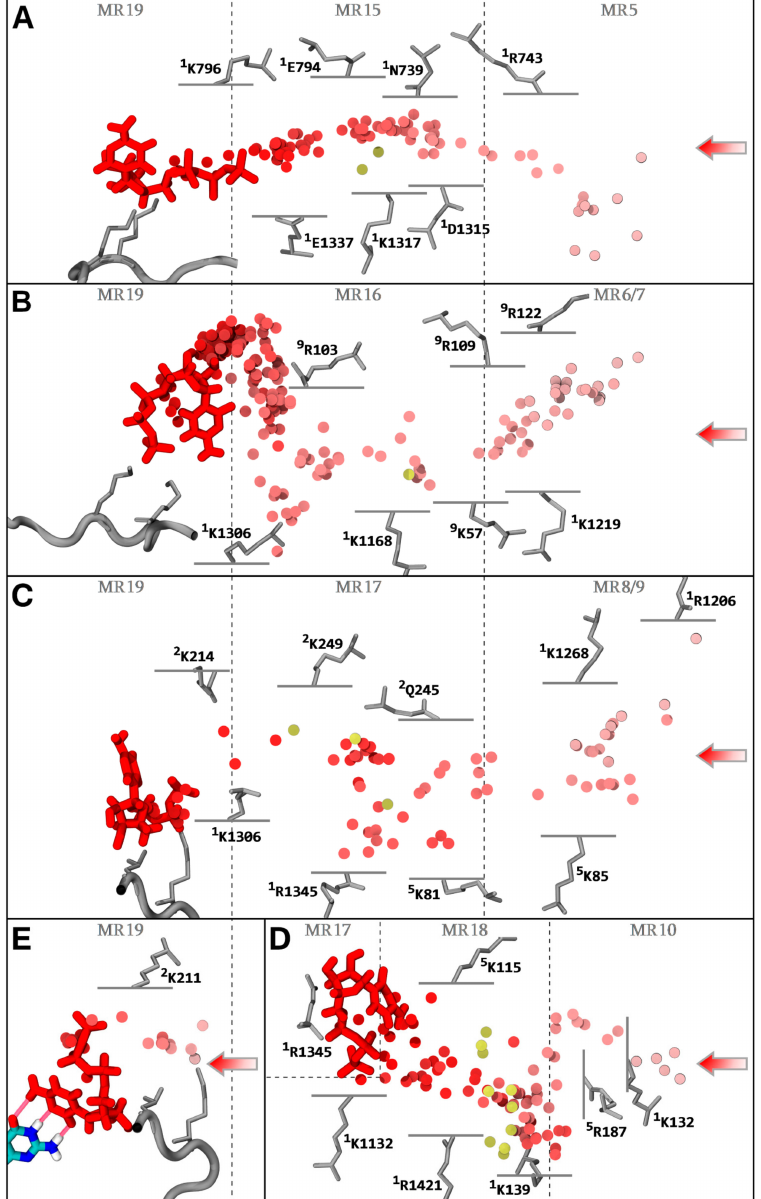
Figure 6. NTP loading through CH1. The center of mass of the NTP-MgB molecule along the di ff usion trajectories is shown as a series of discs, color coded from light red to red, chronologically. The NTP substrate (MgB not shown) at the end ( A – E , red) of the displayed trajectory, and the i + 1 dNMP DNA register (( E ) colored by atomic type), are shown in stick representation. The hydrogen bonds completing the CH1 di ff usion process ( E ) are represented as translucent red tubes. Key amino